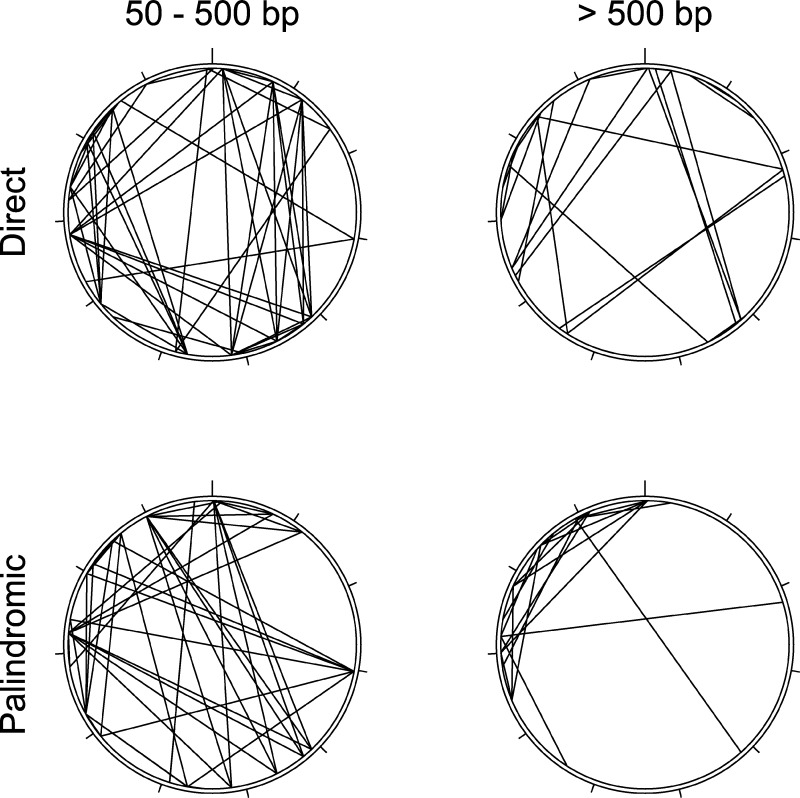
Organization of Direct and Palindromic Repeats in wBmCircles represent the complete genomic sequence of wBm. Repeats were identified using the REPuter program [182] and are connected by line segments. Direct repeats are shown in the graphs in the top row, while palindromic repeats are shown in the lower row of graphs. The left column graphs display repeats of 50 to 500 bp in length. The rightmost graphs display repeats of greater than 500 bp in length.